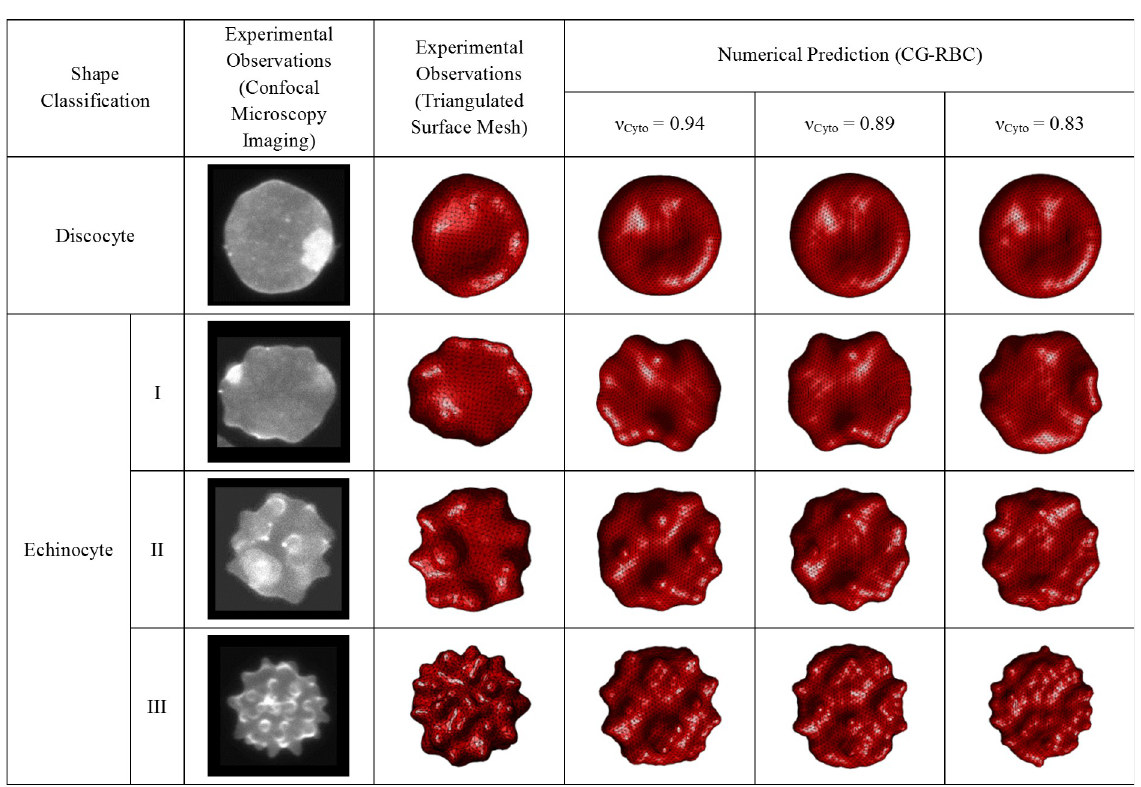
Fig 10. Qualitative comparison between corresponding experimentally observed and CG-RBC membrane model predicted discocyte, echinocyte I, echinocyte II and echinocyte III shapes at cytoskeletal reference states of n and